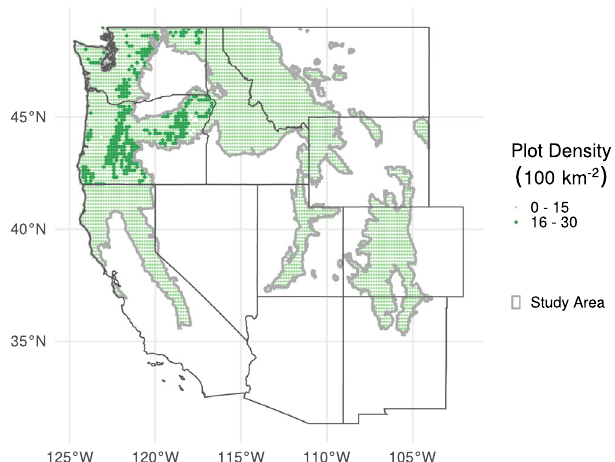
Fig. 1 Map of the study area. The Northwestern Forested Mountains and Marine West Coast Forest ecoregions (thin gray outline) of the northwestern continental United States determined the extent of the FIA plots (green points) that were sourced. Larger and darker points represent areas that were sampled at a greater geographic density. Source data are provided as a Source Data